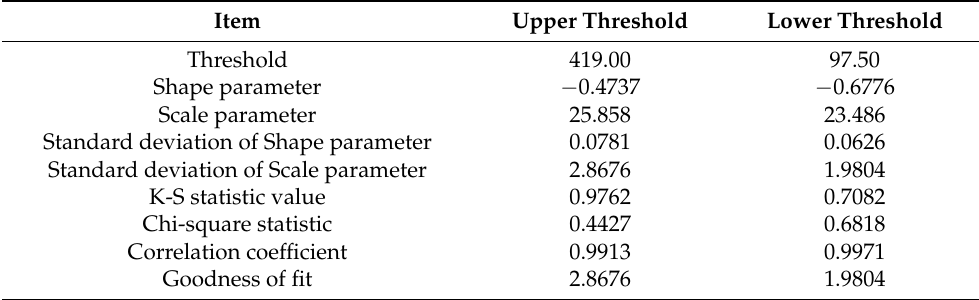
Table 4. Analysis of GPD fitting